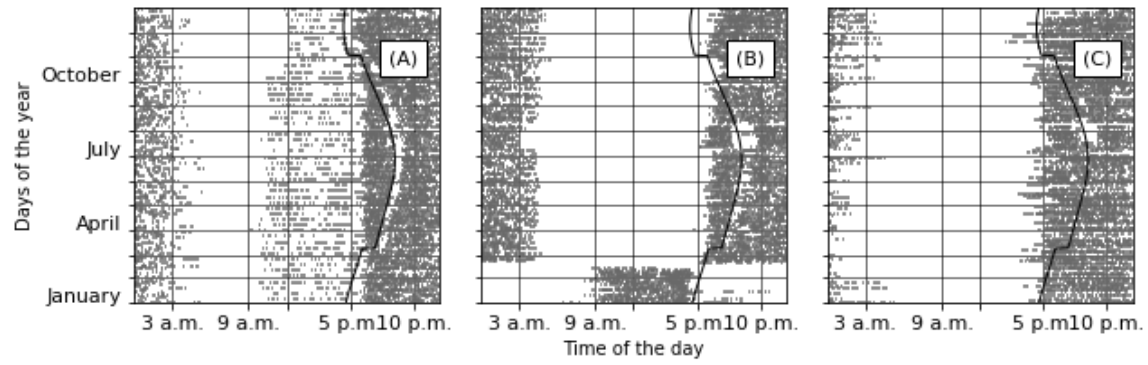
Figure 2: Three taxi drivers with systematic breaks around